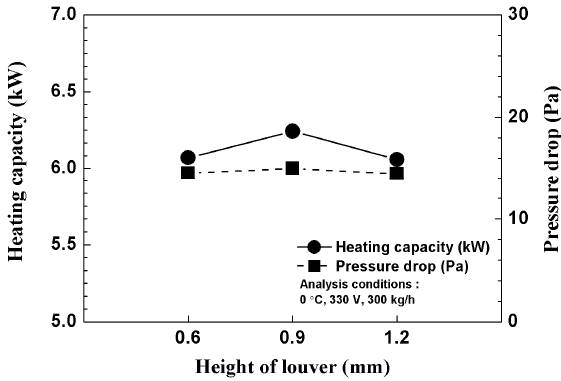
Figure 8. Heating capacity and pressure drop variations for di ff erent heights of the modified louver.